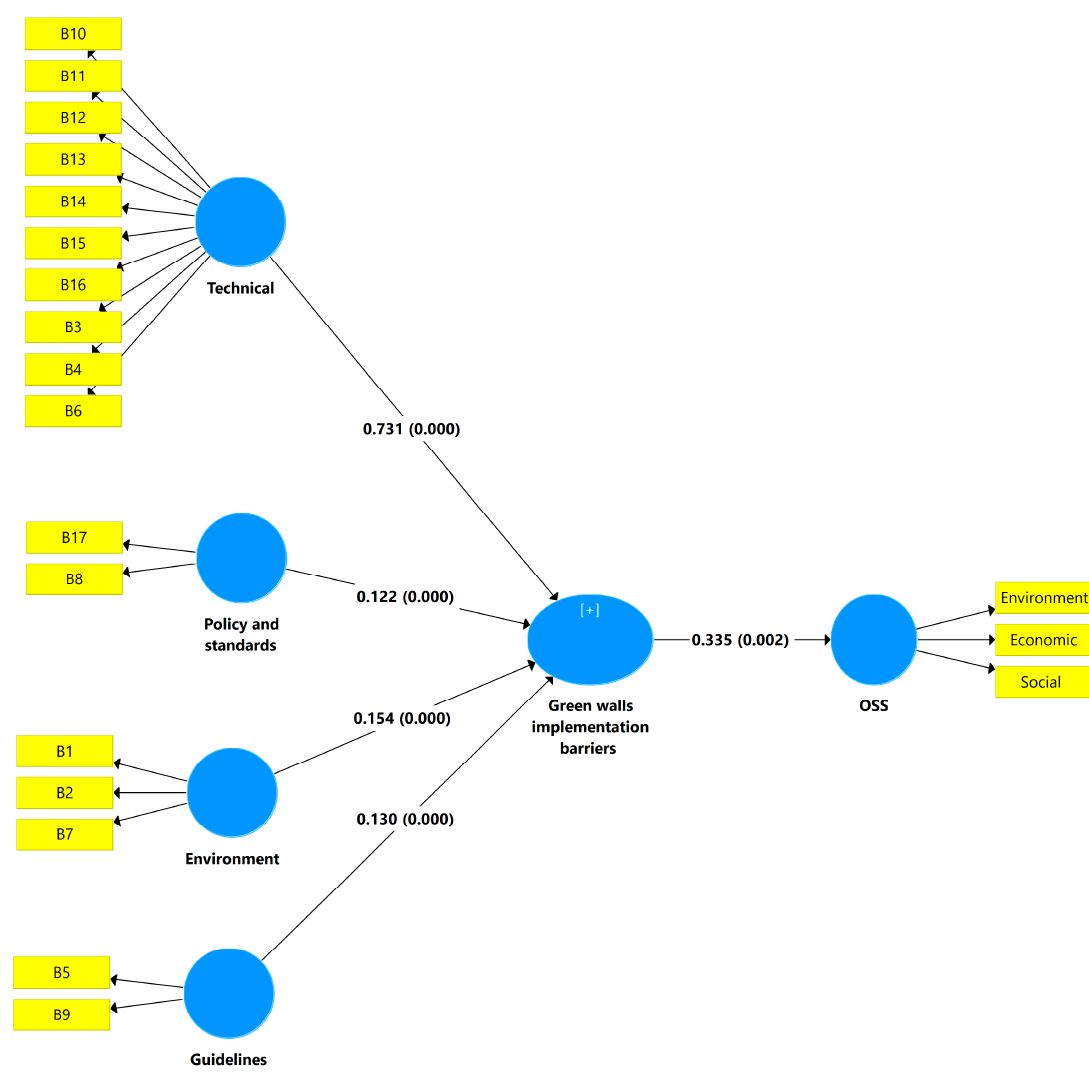
Figure 5. Path analysis.